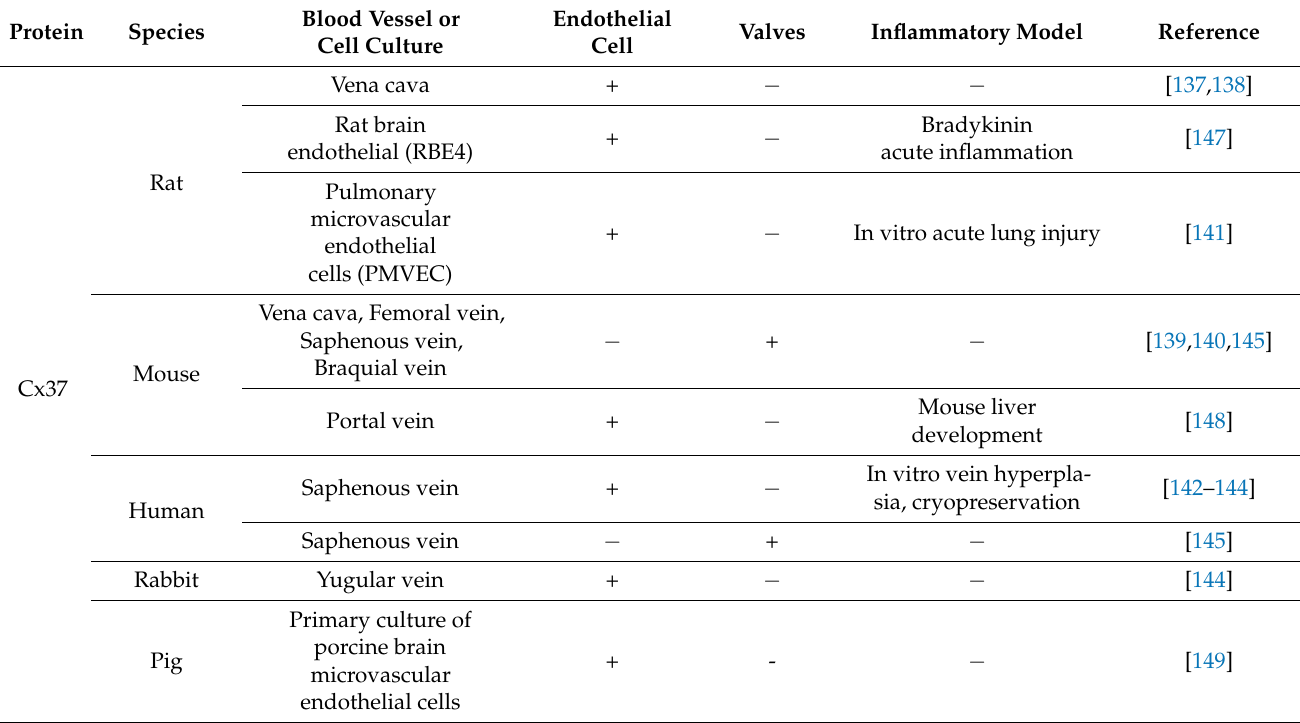
Table 2. Connexin and Pannexin protein distribution in in vivo veins, venules, and in vitro cell models (+ expression/ − not